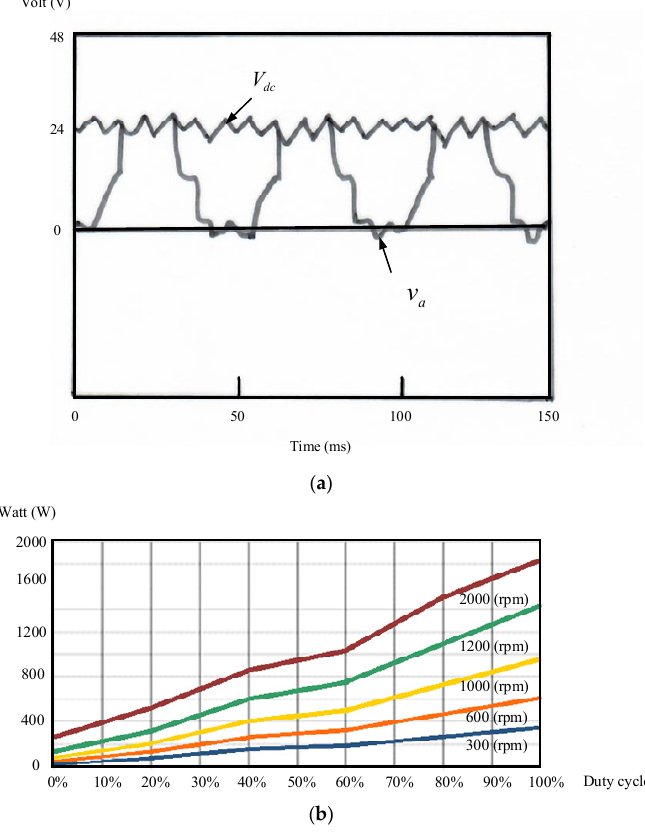
constraint. Figure 23a–c show the measured responses when the motor parameters are varied. The predictive controller has better performance than the PI controller again. Fig- ure 24a,b shows responses of the PI current controller and the new parameters of the pre- dictive current controller. No torque sensor is used here. However, we can judge the torque ripples from the q-axis current ripples and speed ripples. As you can observe, from Figure 24a,b, the torque ripples between the predictive control and PI control are quite close. Therefore, we can conclude that the predictive controllers provide better transient responses but not better torque ripples than the PI controllers. Figure 17. Measured regeneration voltage waveforms and power. ( a ) voltage waveforms, ( b ) power. Figure 18a shows the measured voltage waveform when the relay is switched from